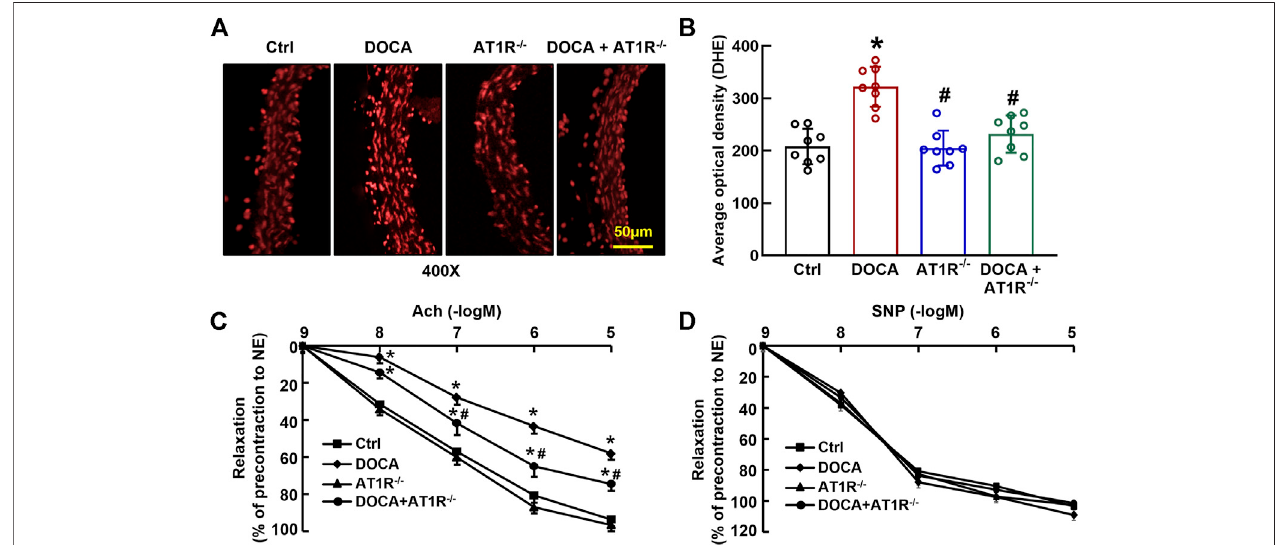
FIGURE 8 | Myeloid AT1R gene de fi ciency reduced aortic ROS production and improved endothelial function in DOCA/salt hypertensive mice. Representative imagesofROS fl uorescenceintensitystainedbyhydroethidine (A) ;quantitativeanalysisofaorticROSproduction (B) ;endothelium-dependentrelaxationtoacetylcholine (C) ; endothelium-independent relaxation to sodium nitroprusside (D) . Statistical comparisons were carried out with two-way ANOVA (B) or two-way ANOVA repeated measurements (Cand D) followed bythe Tukey post hoc test. Datawere expressed asmean ± SEM. N =8, * p < 0.05 vs. control mice, # p < 0.05 vs. DOCA